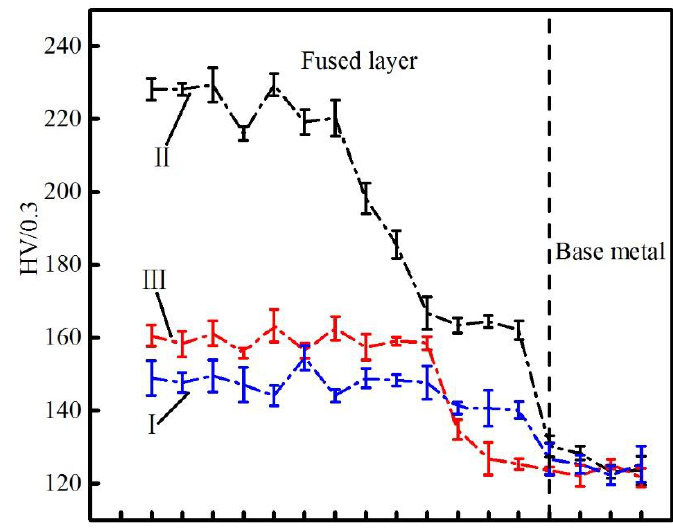
Figure 8. Hardness curves measured along the centerline: I (CC 0.2 m/min), II (CC 0.3 m/min), and III (PC 0.2 m/min).